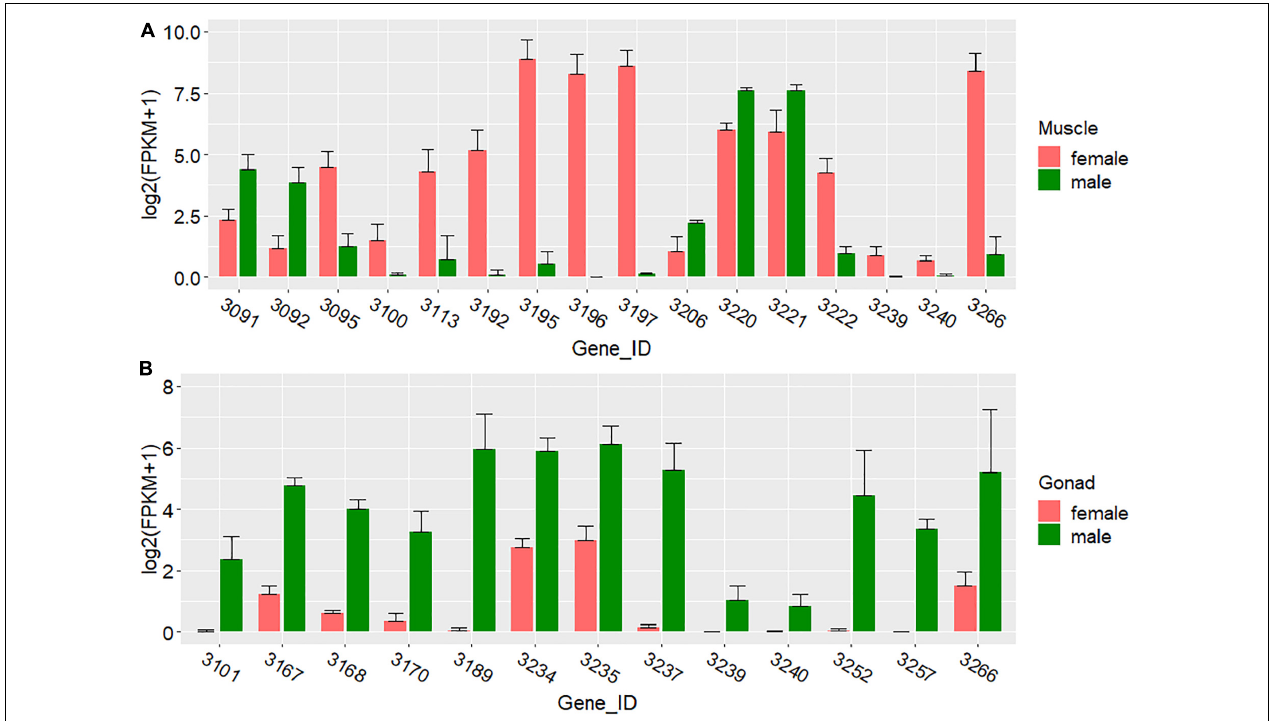
FIGURE 5 | Expression of DEGs in the 34–37 Mb interval of Chr7. (A) Expression in the muscle. (B) Expression in the